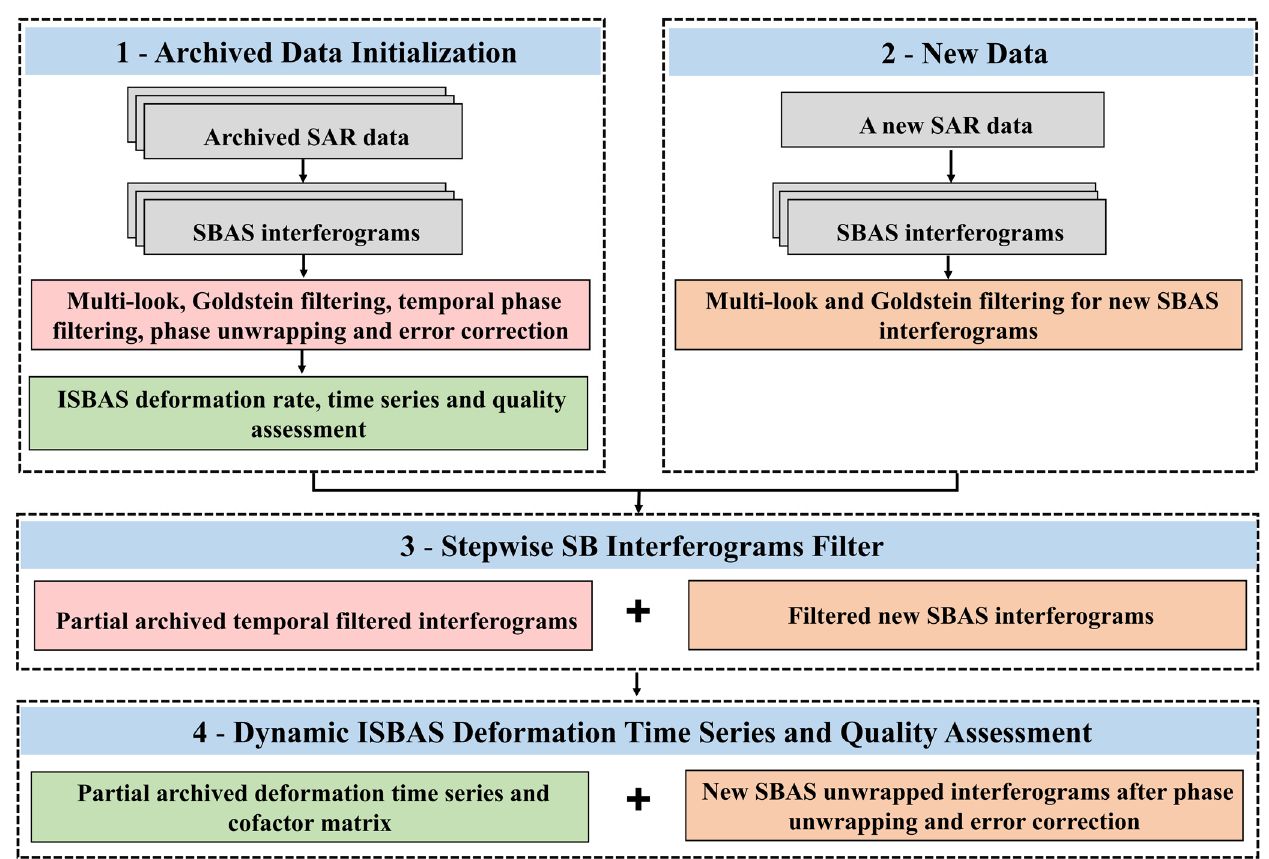
Figure 1. Flow chart of the proposed approach.